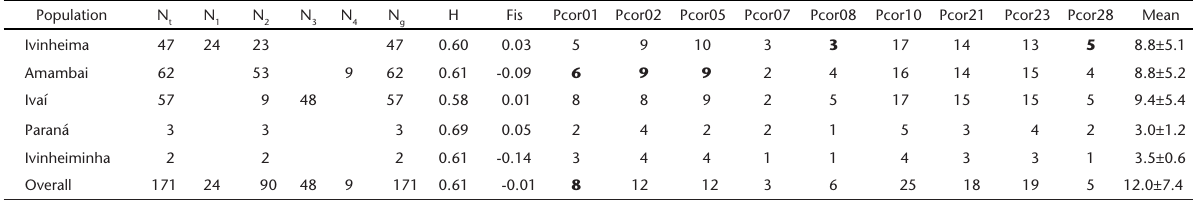
Table 1. Number total (N) and per reproductive period (October to March – N 2016) of larvae of Pseudoplatystoma spp. sampled, gene diversity (H), inbreeding coefficient (Fis), number of alleles of each 9 microsat- ellites loci. Bold numbers of Fis represent significant values (p < 0.05) and bold number of the number of alleles represent deviation of Hardy-Weinberg equilibrium (p < 0.0177 after B-Y correction).